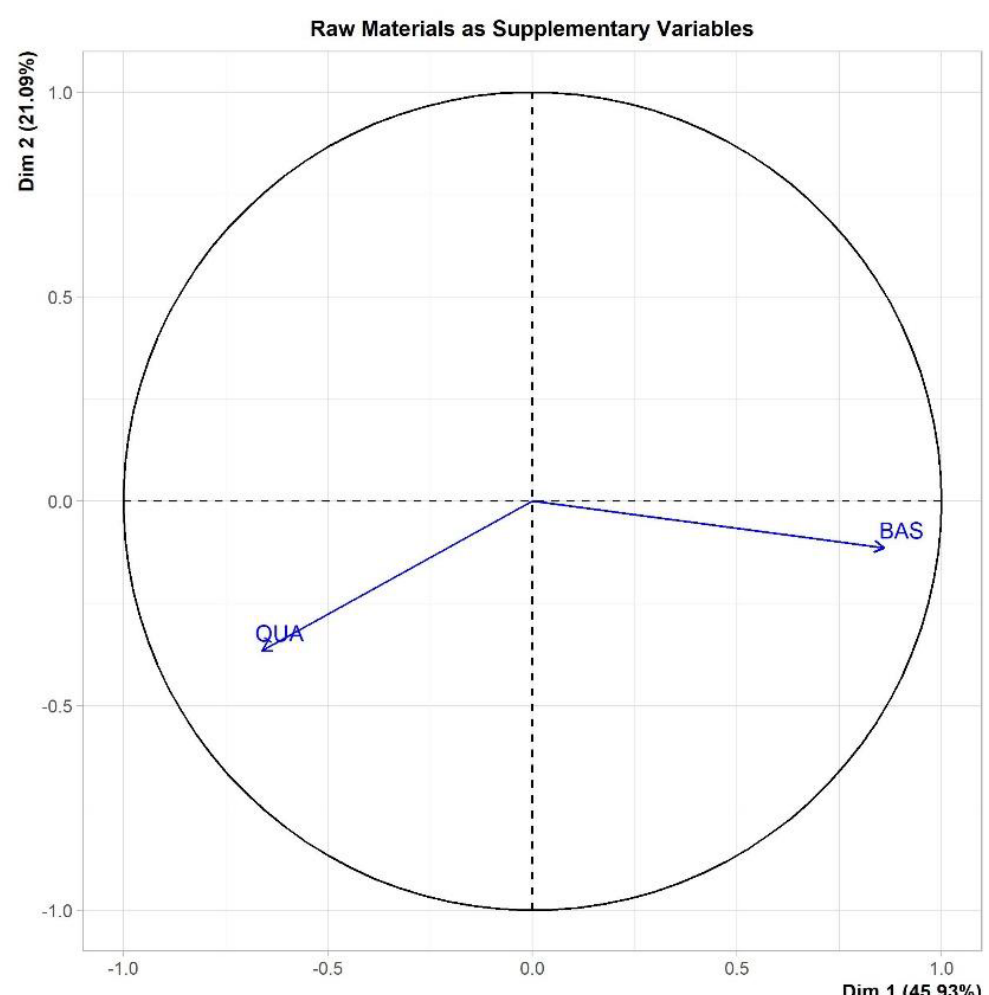
Figure 14: graph showing the disposition of raw material as supplementary variable for flake